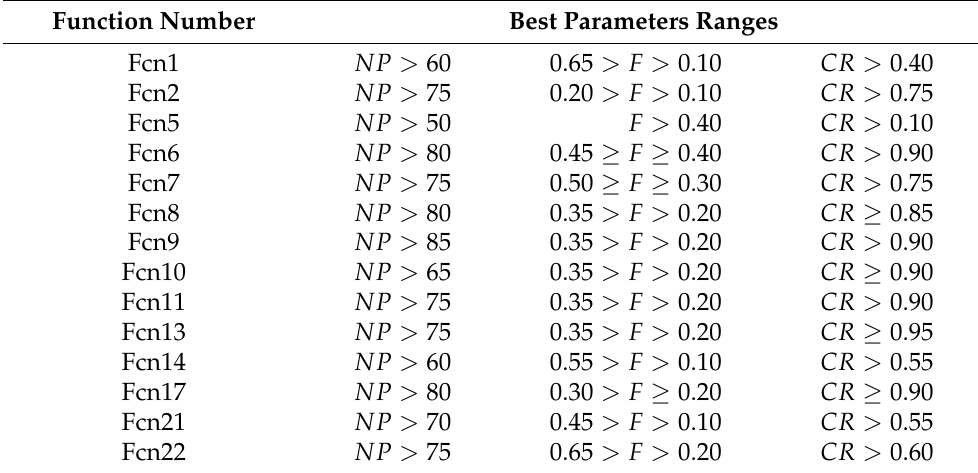
Table 4. The first case objective functions and their respective best parameters